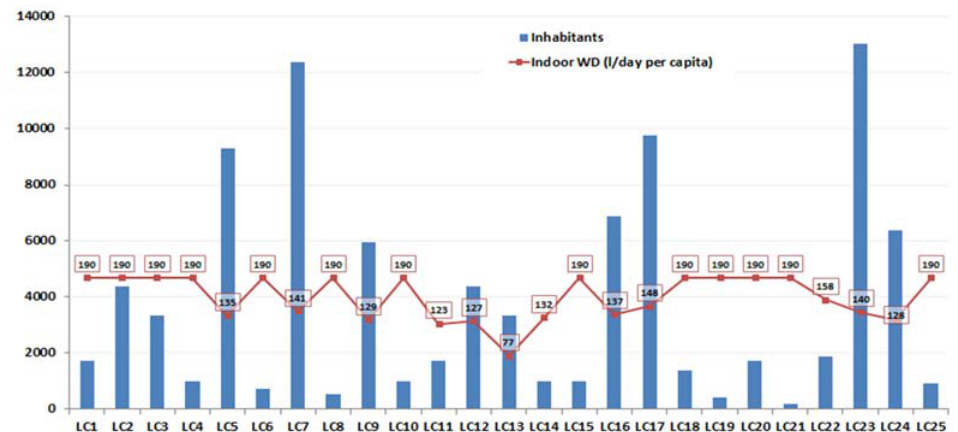
Figure 4. Local areas served by the UWS, with correspondent inhabitants and water demand resulting from indoor